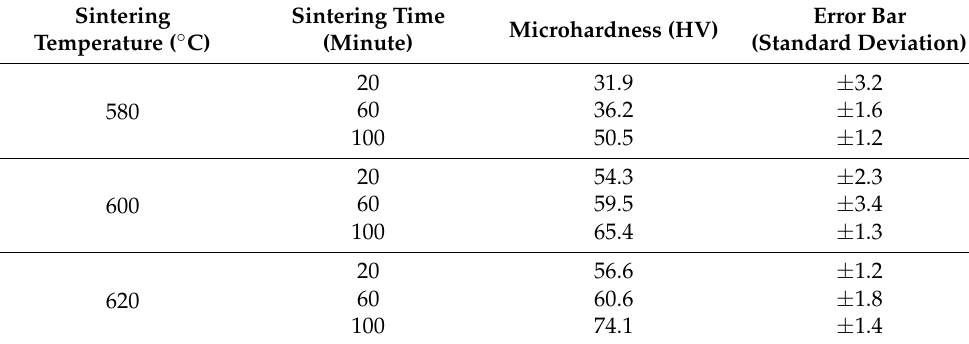
Table 4. Microhardness of sintered